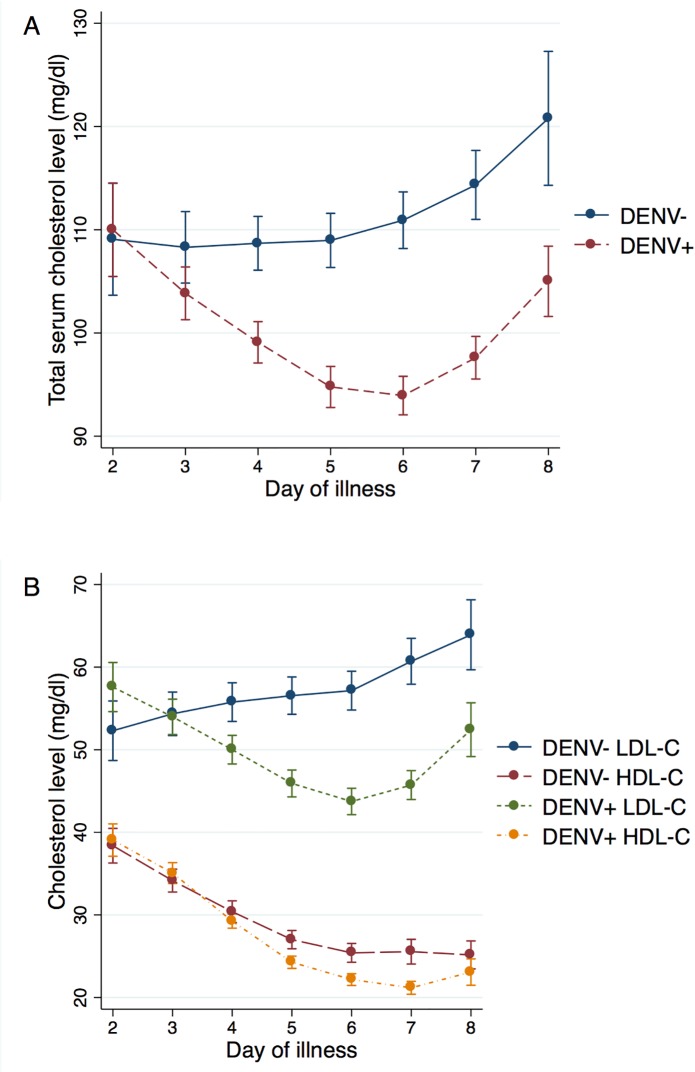
Age- and gender-adjusted marginal mean cholesterol levels (mg/dl) by DENV infection status and day of illness.The day of fever onset was defined as day 1 of illness. A, Total serum cholesterol levels were significantly lower in dengue-positive patients compared to dengue-negative patients on days 3–8 of illness (p<0.05). Among dengue-positive patients, LDL-C levels decreased from day 2–6 of illness, and then increased from day 6–8 of illness. However, among dengue-negative patients, total serum cholesterol levels gradually increased from day 2–8 of illness. B, Trajectories of LDL-C levels were similar to those of total serum cholesterol levels. Among dengue-positive patients, LDL-C levels decreased from day 2–6 of illness, and then increased from day 6–8 of illness. Among dengue-negative patients, LDL-C levels gradually increased from day 2–8 of illness. LDL-C levels were significantly lower in dengue-positive patients compared to dengue-negative patients on day 2 (p<0.05) and days 4–8 of illness (p<0.001). In contrast, HDL-C levels were significantly lower only on days 5–7 of illness (p<0.001). HDL-C levels followed a similar trajectory among both dengue-positive and dengue-negative patients, decreasing from day 2 to day 6–7 of illness before stabilizing or increasing slightly on day 7–8 of illness. For all cholesterol trajectories, a global test for multiple comparisons across all time-points showed that the differences remained significant at the p<0.05 level.